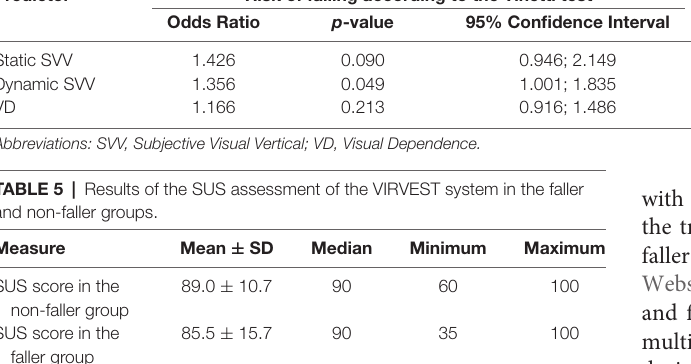
TABLE 4 | The relationship between the risk of falling according to the Tinetti test, the faller group, and the results of static SVV, dynamic SVV, and VD evaluations. Predictor Risk of falling according to the Tinetti test Risk of falling according to the clinical history